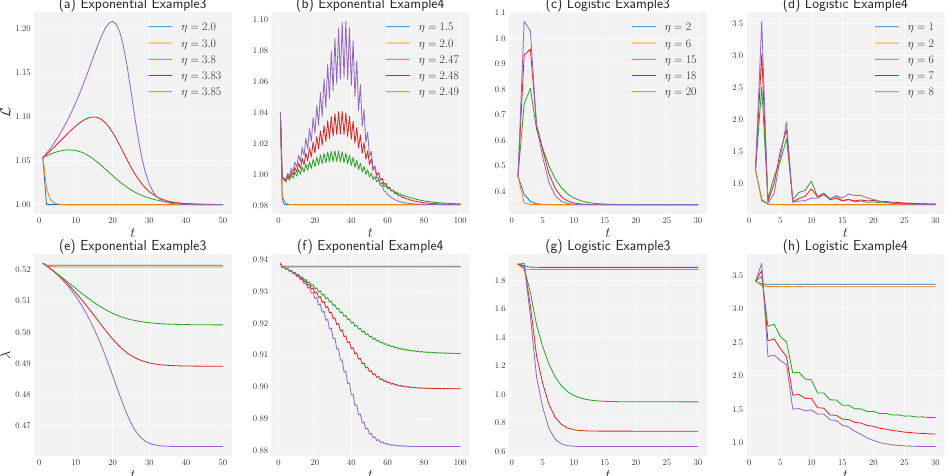
Figure 1. Dependence of dynamics of training loss and maximum eigenvalue of the NTK on the learning rate for a one-hidden-layer linear network, with ( a , b , e , f ) exponential loss and ( c , d , g , h ) logistic loss in Examples 3 and 4. ( a – d ) In a large learning rate regime (the catapult phase), the loss increases at the beginning and converges to a global minimum. ( e – h ) The maximum eigenvalue of the NTK decreases rapidly to a fixed value which is lower than its initial position in the large learning regime (the catapult